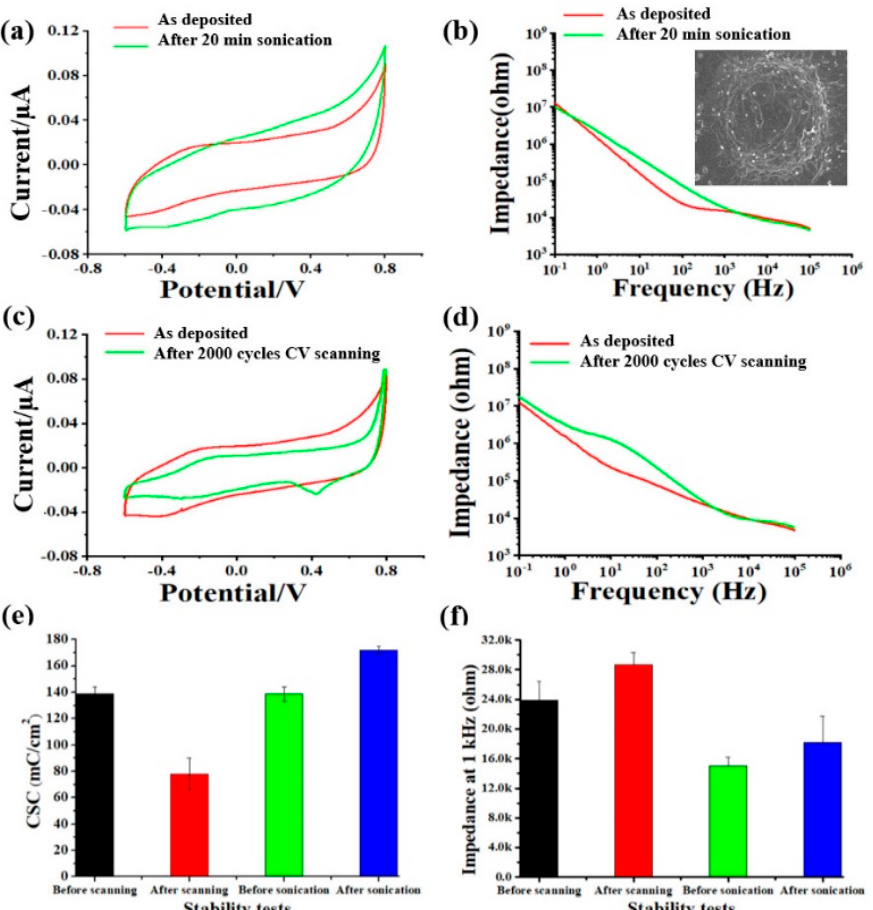
Figure 3. ( a ) Averaged CV plots and ( b ) impedance spectra of the PBK/PGO modified microelectrode before and after 20 min of ultrasonication ( n = 3). The inset shows SEM picture of one PBK/PGO modified microelectrode after 20 min of ultrasonication. Corresponding ( c ) CV plots and ( d ) impedance spectra before and after 2000 cycles of CV scanning ( n = 3). ( e ) Histogram of ( e ) CSC and ( f ) impedance at 1 kHz of PBK/PGO modified microelectrode before and after stability tests.